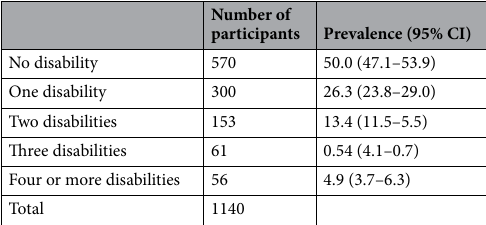
Table 4. Prevalence of number of non-communicable diseases with 95% confidence